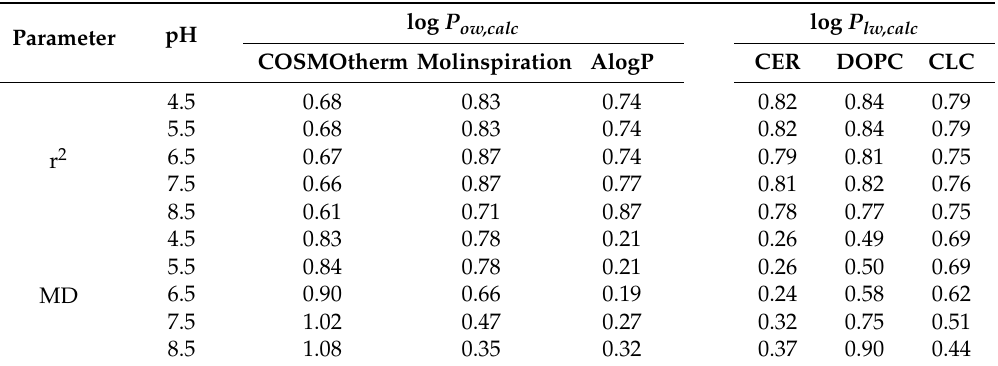
Table A5. Correlation coefficient (r 2 ) and mean differences (MD) of n -octanol/water partition coefficient (log P ow,calc ) to log P ow,exp measured at different pH and calculated lipid/water partition coefficient (log P lw,calc ) in model membranes.